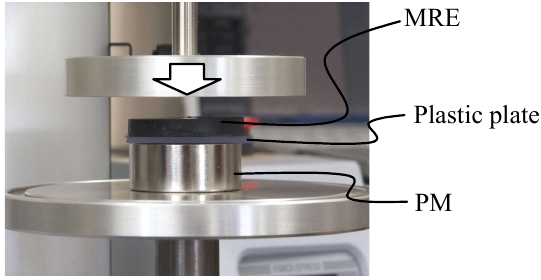
Figure 6. Compression apparatus and setup for a specimen. Three different magnets with the same diameter were used.